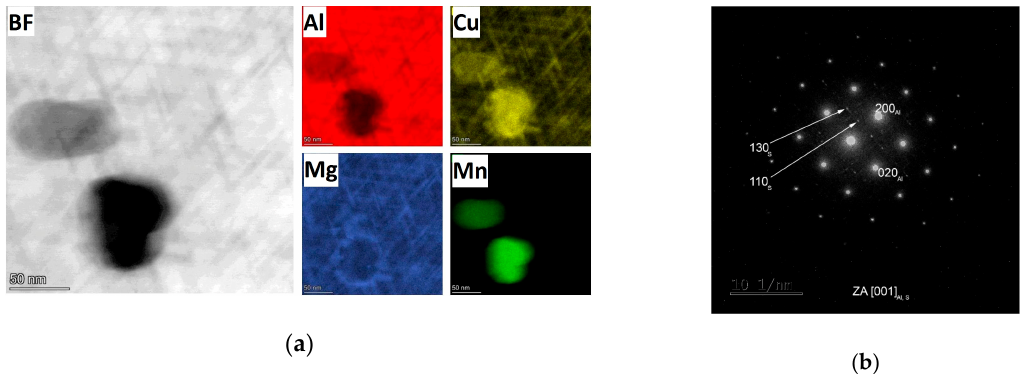
Figure 15. ( a ) EDS maps of specimen W-1RS-180; ( b ) Selective electron diffraction pattern of the Al matrix in the zone axis [001]: the Al matrix is represented by bright spots in a rectangular pattern, The S-phase is shown as dimmer spots between the bright ones.